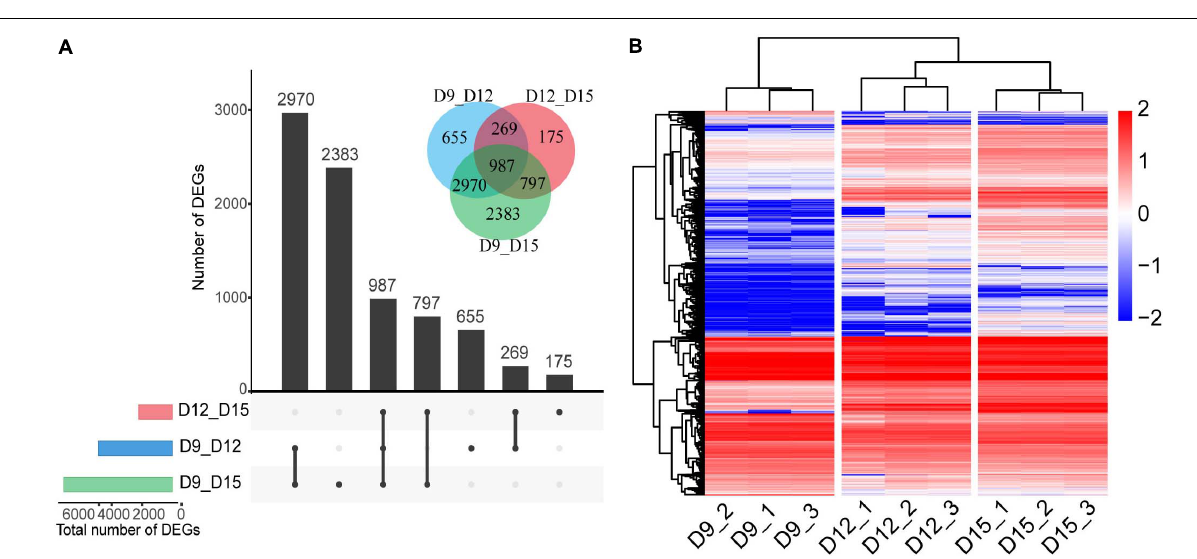
their analogical expressions pattern. The first cluster